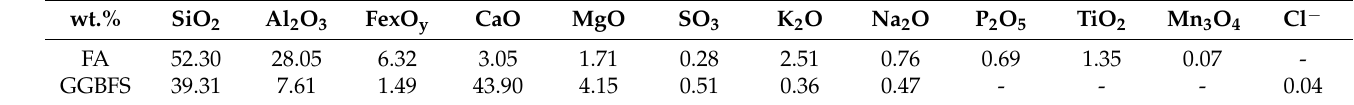
Table 1. Chemical compositions of FA and GGBFS used in the presented research.